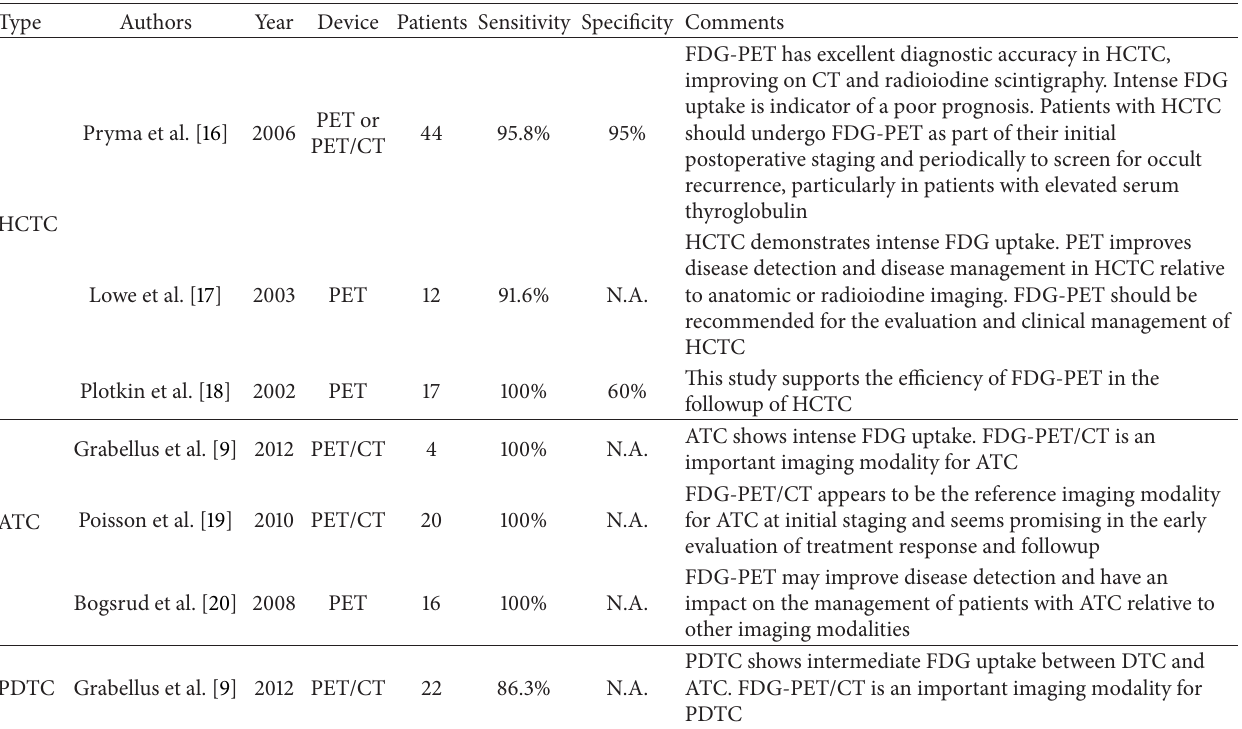
Table1:MainfindingsaboutFDG-PETorPET/CTinH¨urthlecellthyroidcarcinoma,anaplasticthyroidcarcinoma,andpoorlydifferentiated thyroid